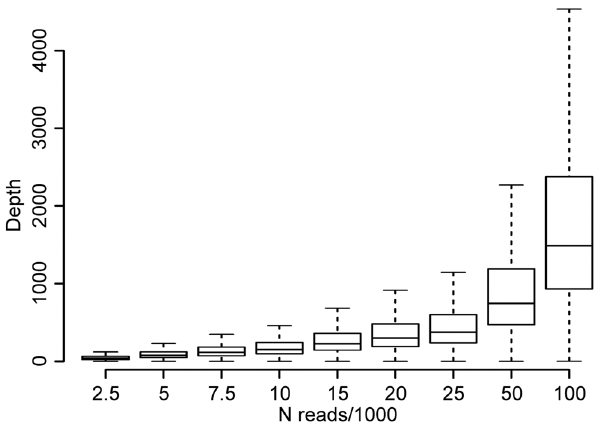
Figure 5. Effect of increasing sequencing effort on coverage statistics. Reads were randomly picked from the largest dataset (FR20RV-12N). This random sampling was repeated 10 times and averages of coverage statistics are displayed in